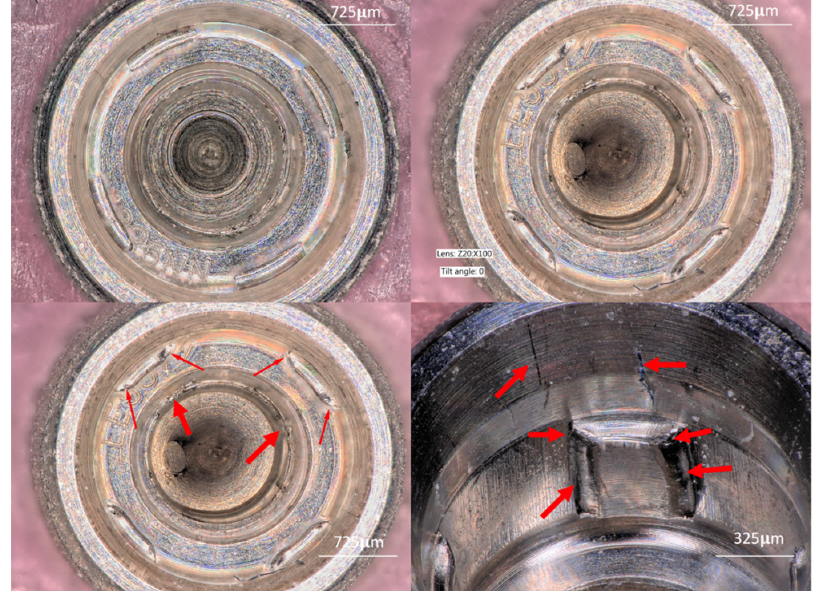
Figure 4. Upper left image shows a Group C (Internal Four-Channeled) narrow implant. The anti-rotational internal boxes, with their lateral walls forming a straight angle with the implant walls. Upper right image shows the deformation of the channel walls. These were deformed after insertion; the sides of the small boxes suffered plastic deformation and were flattened. Lower left image shows red arrows demonstrating titanium particles and deformation of all four channel elements. Lower right image shows the box walls completely deformed, the edges of the wall contained titanium particles. In addition, some scratches are observed.